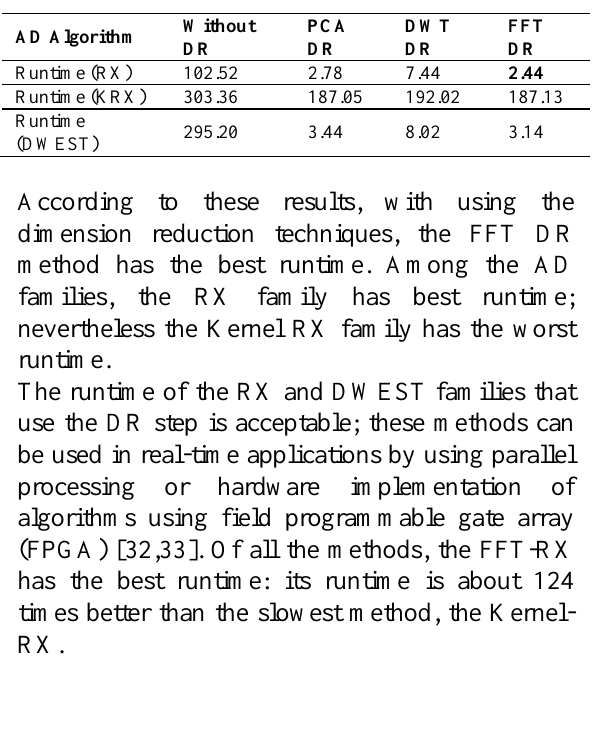
Table 5. Runtime of AD methods applied to Img-III.